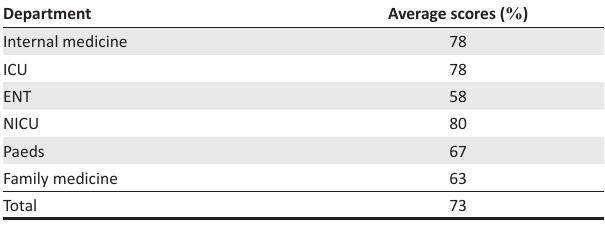
TABLE 3: Knowledge of side effects of ototoxic medicines compared across various